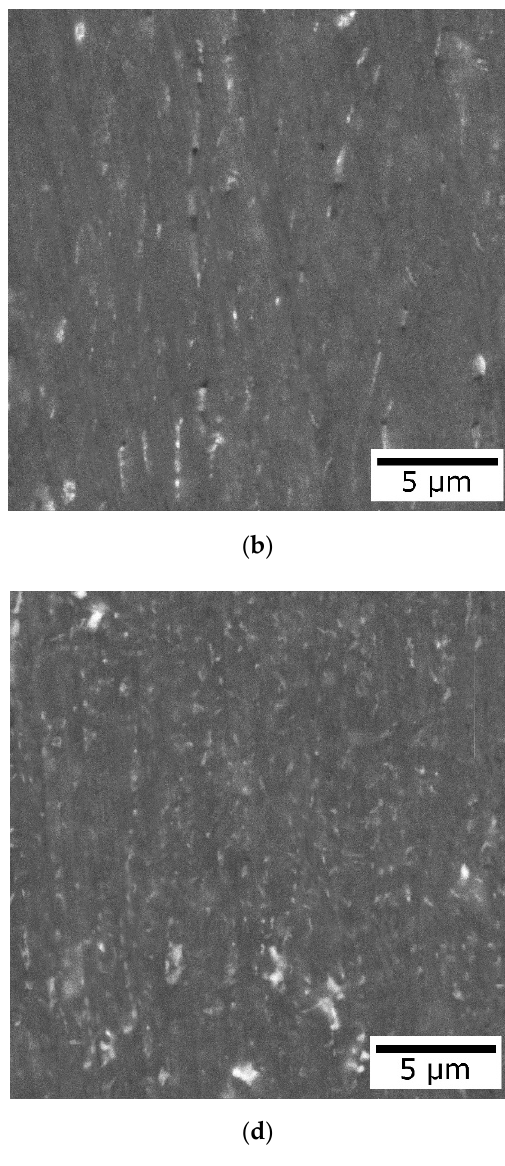
Figure 3. Microstructure of wire alloy ACZ in ( a , c ) 3 mm wire and ( b , d ) 2 mm strip: ( a ), as-drawn, ( b ) as-rolled, ( c , d ) annealed at 600 °C, SEM, ( a ) W, ( b ) S, ( c ) W600, ( d ) S600, designations see Table 2. Table 3. Mechanical and electrical properties of ACZ wire